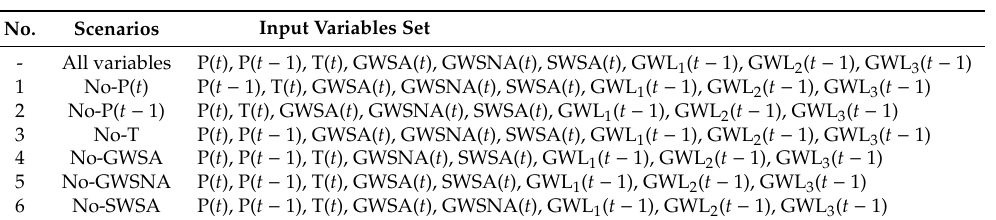
Table 5. Six input scenarios sets for sensitivity analysis.